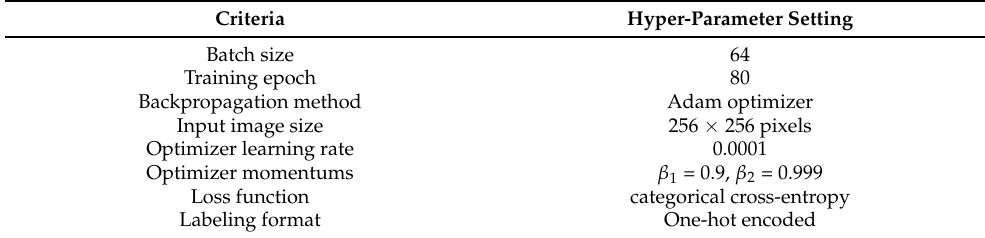
Table 2. Hyper-parameter settings for the